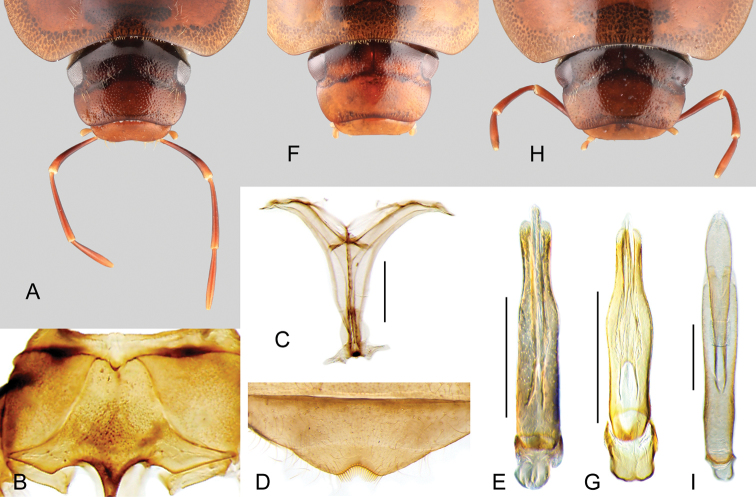
Head and internal structures of Aulonochares spp.: A–EAulonocharestubulus: A head, dorsal view B ventral view of mesoventrite with simply convex posterior elevation C posterior view of metafurca D fifth abdominal ventrite E aedeagus. F, GAulonocharesnovoairensis: F head, dorsal view G aedeagus. H, IAulonochareslingulatus: H head, dorsal view I aedeagus. Scale bars: 0.5 mm.